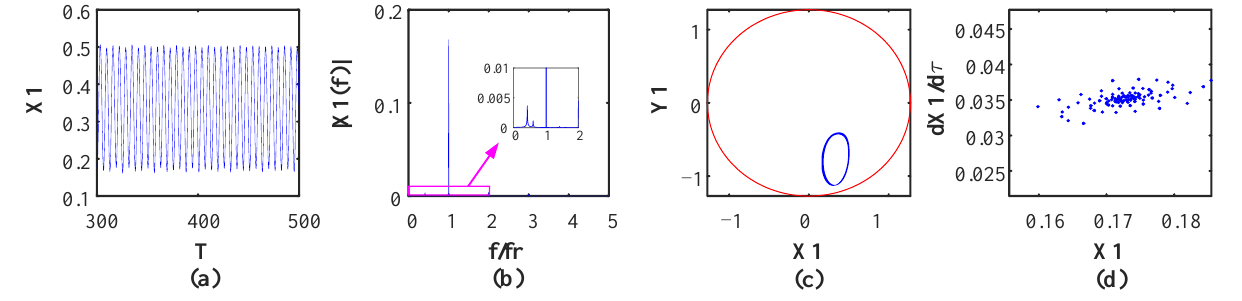
Figure 8. Numerical integration results at ω = 754 rad/s: ( a ) Time domain waveform; ( b ) Frequency spectrum; ( c ) Shaft orbit; ( d ) Poincaré map.